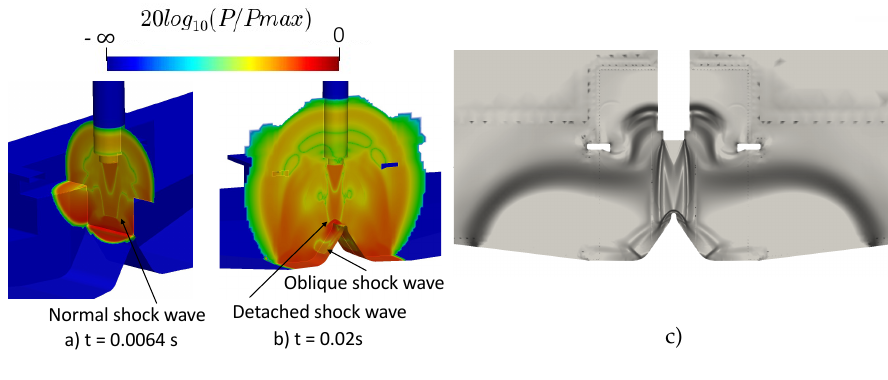
Figure 4. VEGA lift-off environment shock waves’ identification. Normalized instantaneous pressure contour at ( a ) t = 0.0064 s and ( b ) t = 0.02 s. ( c ) Schlieren shock waves’